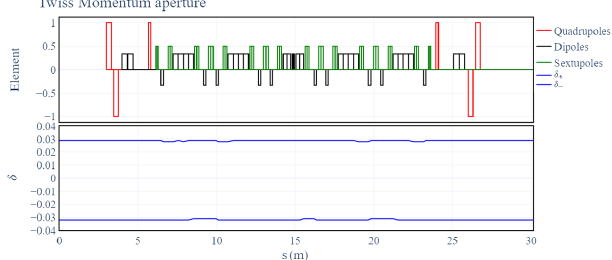
FIG. 21. Elements (top) and local energy aperture (bottom) over the super period with parameters from Table IV.